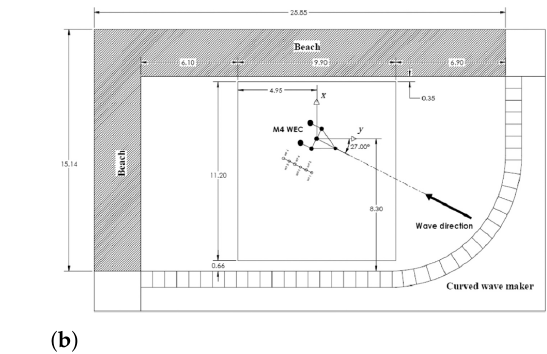
Figure 15. Experimental setup used by Moreno et al., reprinted with permission from Ref. [47], 2019, Moreno et al.: ( a ) six-floater M4 WEC model with dimensions; ( b ) Lir’s Ocean Basin WEC array